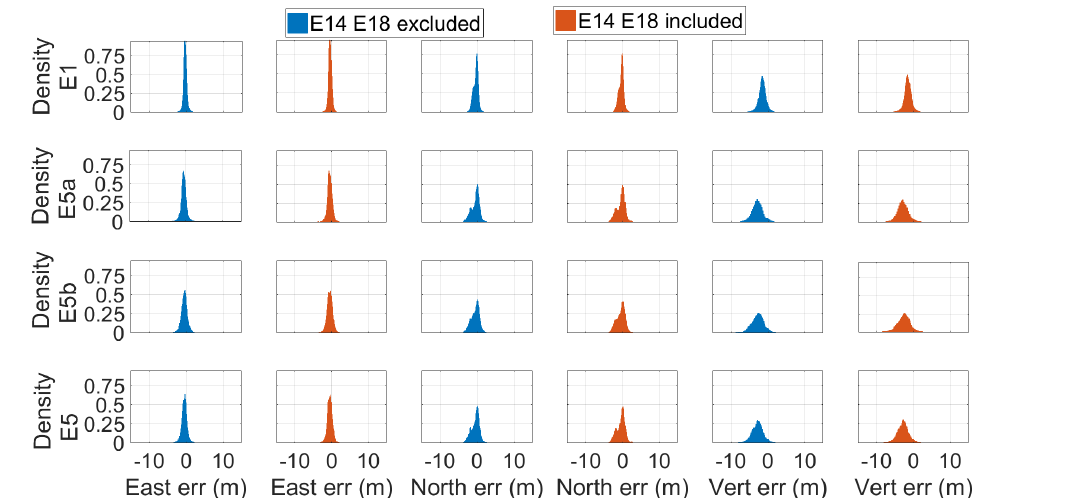
Figure 15. Density histograms of the E1, E5a, E5b, and E5 single-point position coordinates’ error. Each line refers to a specific frequency: the first from above refers to the frequency E1, the second to E5a, the third to E5b, and the fourth to E5. Blue and red histograms were obtained excluding and including the measurements coming from the Milena (E14) and Doresa (E18) satellites, respectively. The solution was achieved by using precise ephemeris.